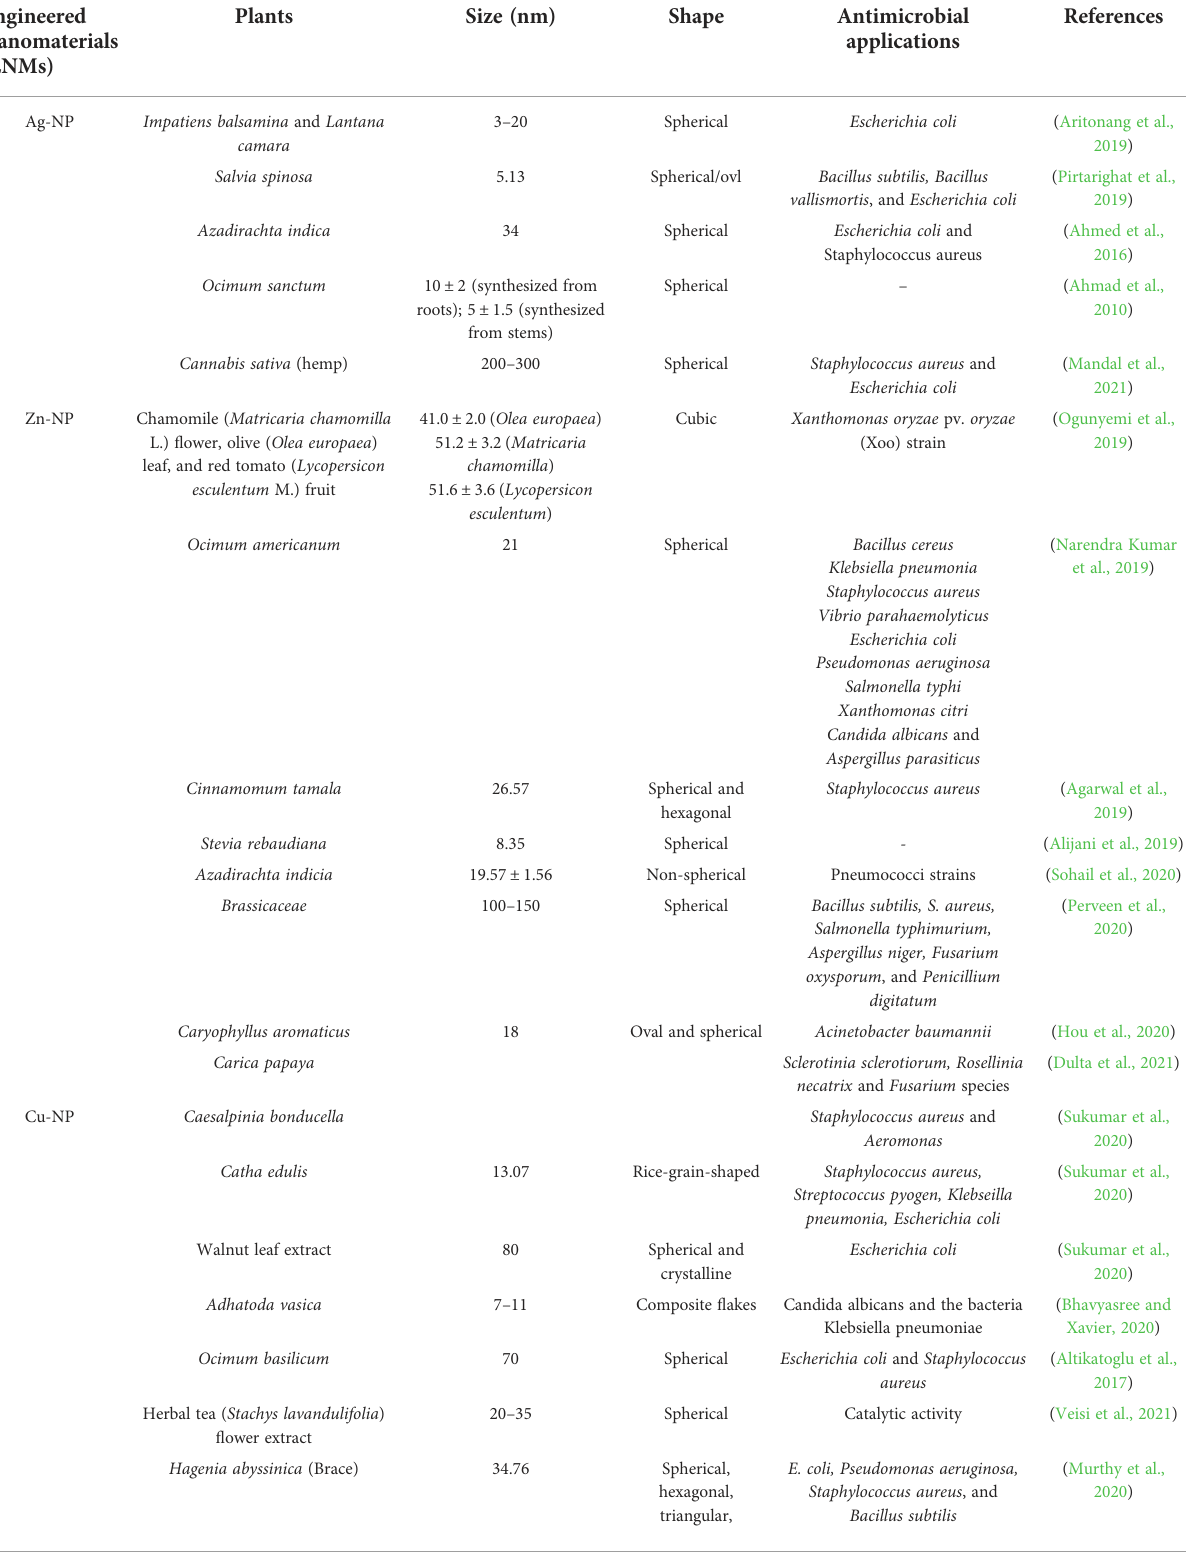
TABLE 1 Applications of Engineered Nano materials in seed